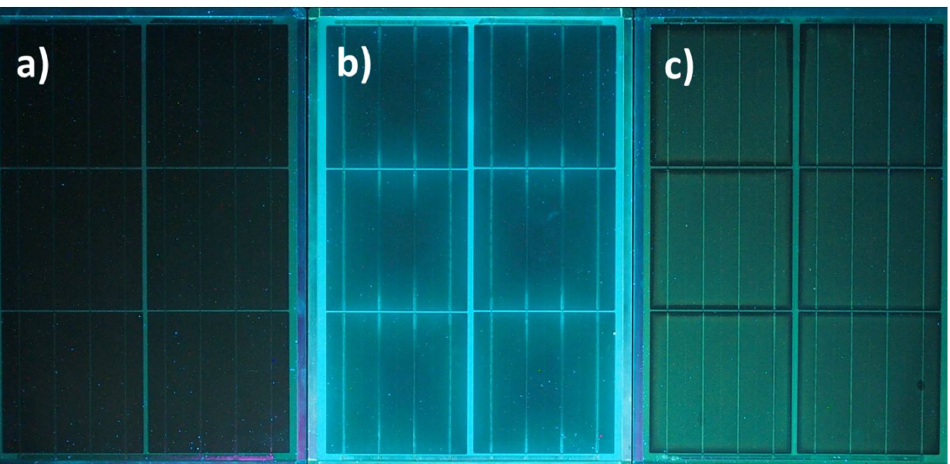
Figure 2. UV-F images of three test modules: ( a ) one in the original state (stabilized); ( b ) one after storage under DH -conditions for 2000 h; and ( c ) one after exposition to artificial sunlight (1000 W/m 2 ) for 1000 h.